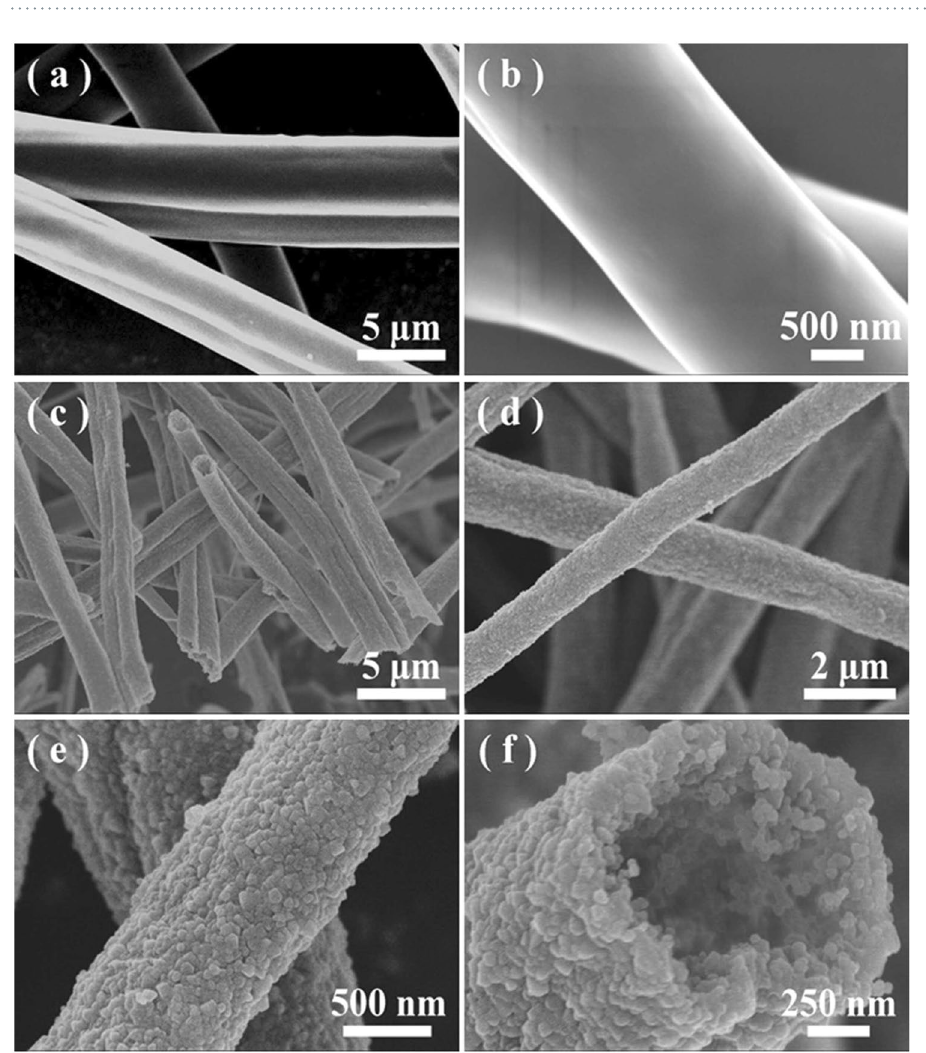
Figure 1. ( a and b ) Typical SEM images of the as-spun PVP/PSN fibers of Sample E. ( c and d ) Typical SEM images of the pyrolyzed products under different magnifications. ( e ) Representative SEM images of the surface structures of the as-fabricated mesoporous SiC hollow fibers. ( f ) A representative SEM image showing the fracture surface of the mesoporous hollow